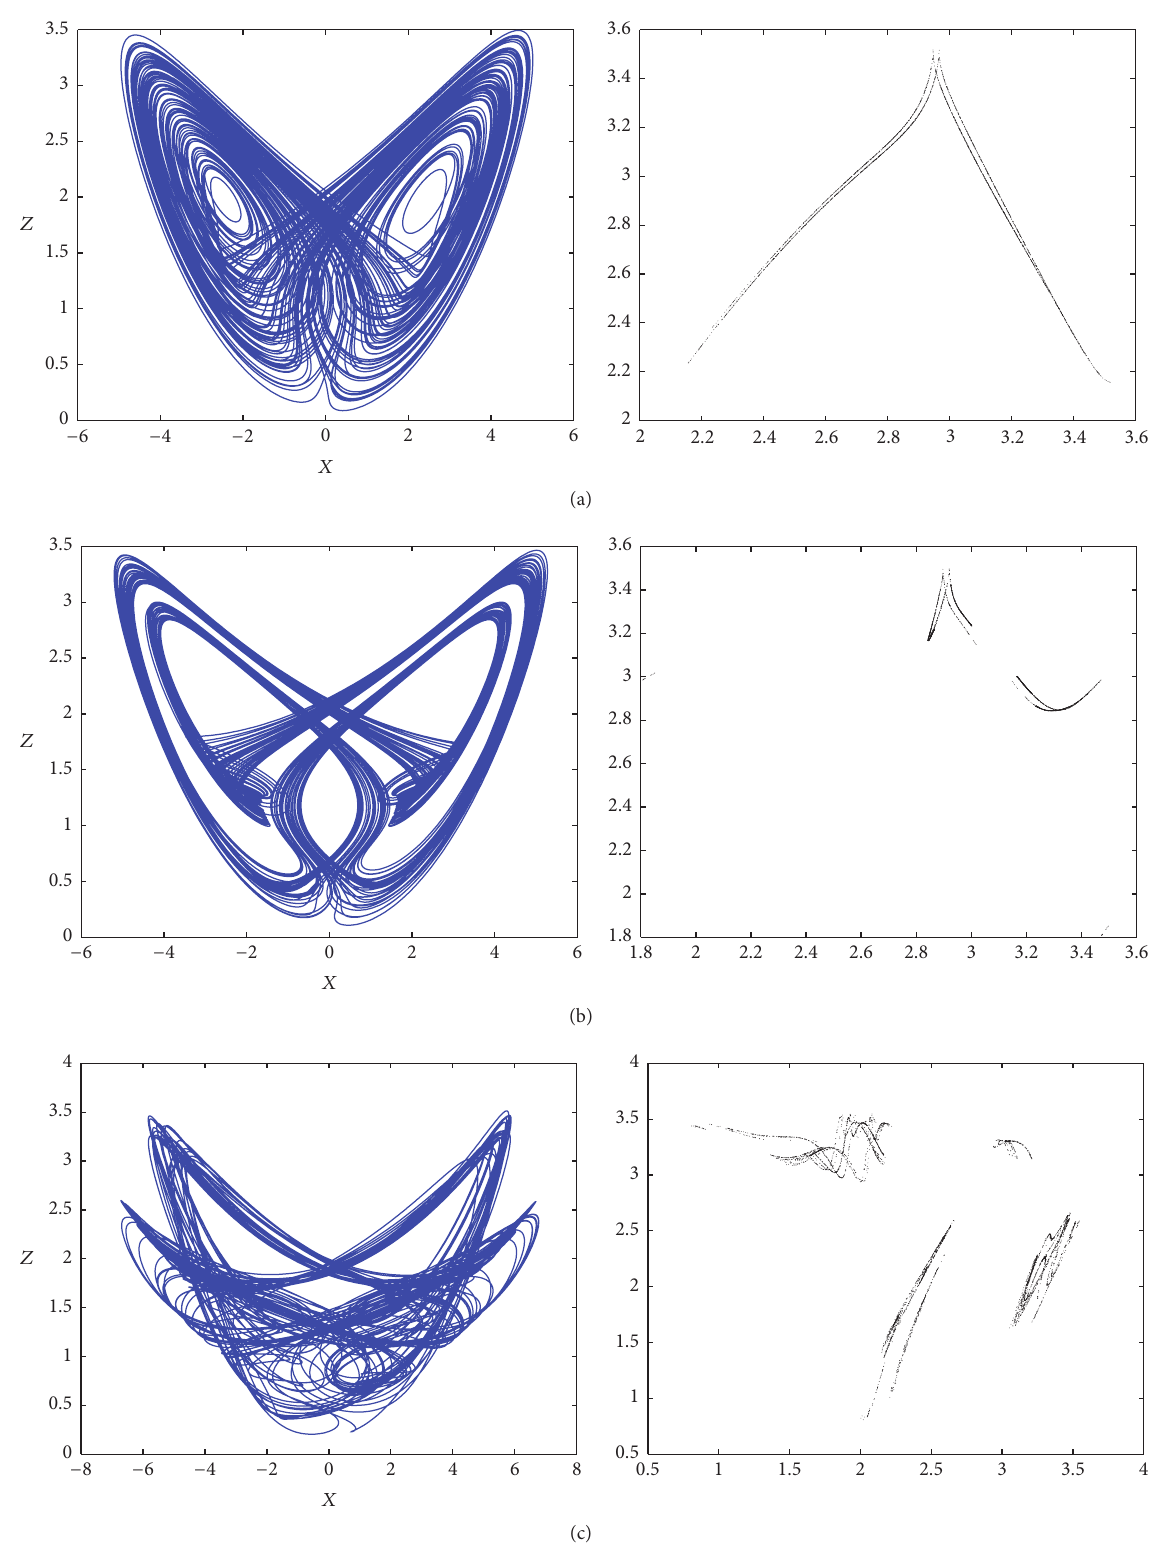
Figure 12: Chaotic attractors of the XZ components generated by the proposed system and first return maps obtained from 𝑍 -component. Initial conditions: (0.1,0.1, 0.1, 0.1) . Parameters: (a) {𝑎 = 20 and 𝑑 = 7} , (b) {𝑎 = 32 and 𝑑 = 5} , and (c) {𝑎 = 40 and 𝑑 = 2}